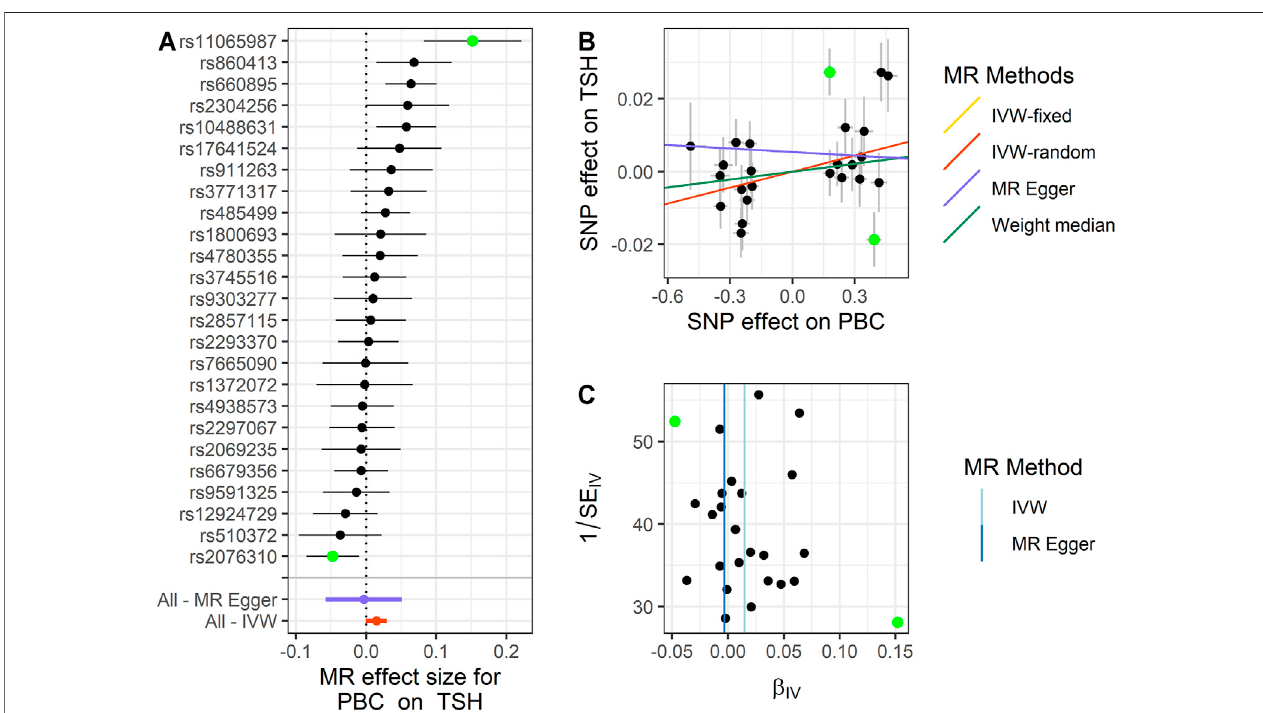
FIGURE 3| Summary ofthe MR analysis for PBC on TSH. (A) MR effect size of each IV, MR-Egger, and IVW. (B) The scatter plot ofcausal effects of PBCon TSH. Weuseverticalandhorizontalblacklinestoshow95%CIoftheestimatedeffectofIVsonPBC(x-axis)andthatonTSH(y-axis),respectively.Weusetheredlinetoshow the IVW random-effects model. The potential SNP outlier (rs11065987 and rs2076310) is highlighted in green. (C) The funnel plot of the causal effect of PBC on TSH. EachpointrepresentstheestimatedcausaleffectofeachIV.TheverticaldarkbluelinerepresentsthecausaleffectestimateobtainedusingtheMR-Eggermethod; the light blue line represents the causal effect estimate obtained using the IVW method. The potential SNP outlier (rs11065987 and rs2076310) is highlighted in green. MR, Mendelian randomization; PBC, primary biliary cholangitis; TSH, thyroid-stimulating hormone; IV, instrumental variable; IVW, inverse variance weighting; SNP, single-nucleotide